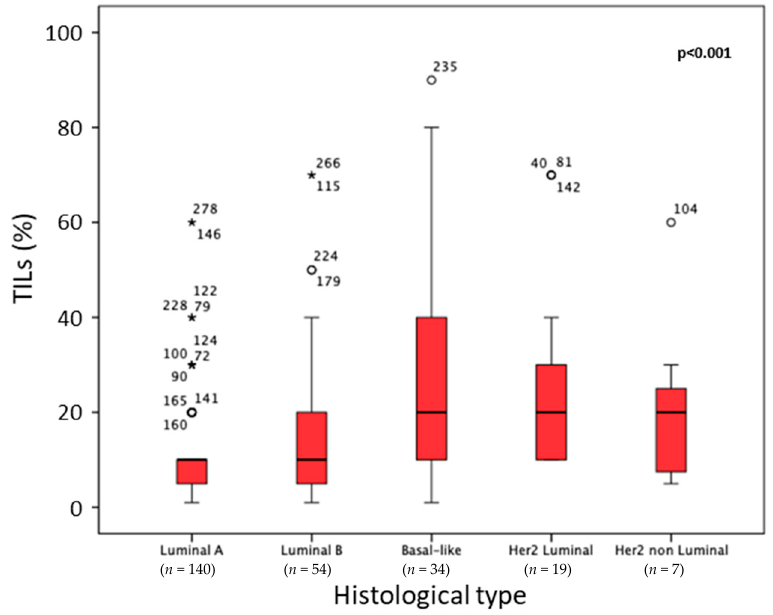
Figure 3. TIL density is significantly higher in basal-like- and Her2-positive cases compared with luminal A and luminal B cases ( p < 0.001). The numbers represent outliers, and the circles represent outlier cases. Extreme outliers are marked with an ( ★ ) on the boxplot.